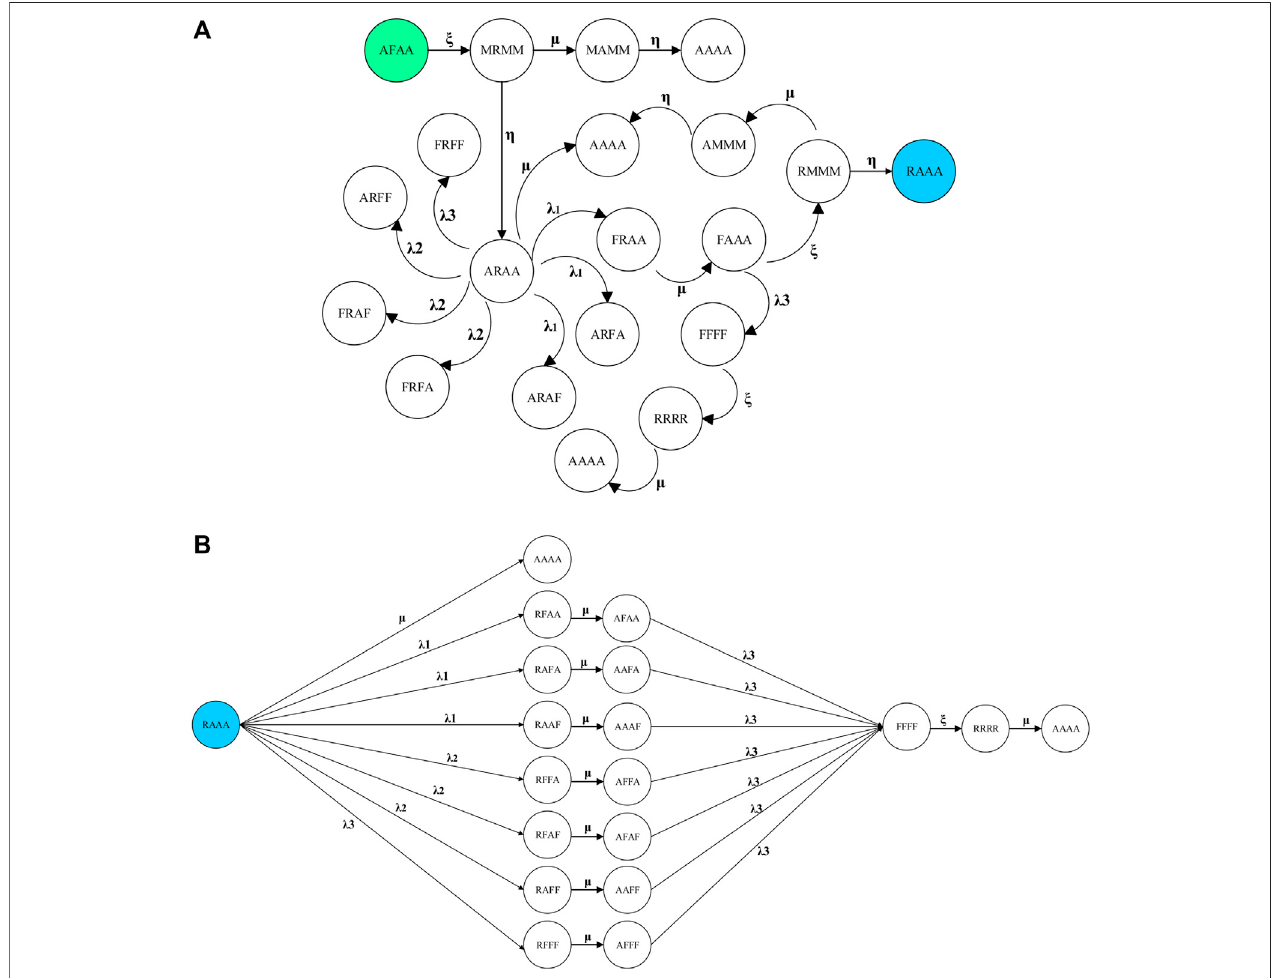
FIGURE 3 | Sample transition diagrams of policy 3: (A) AFAA state and (B) RAAA state.